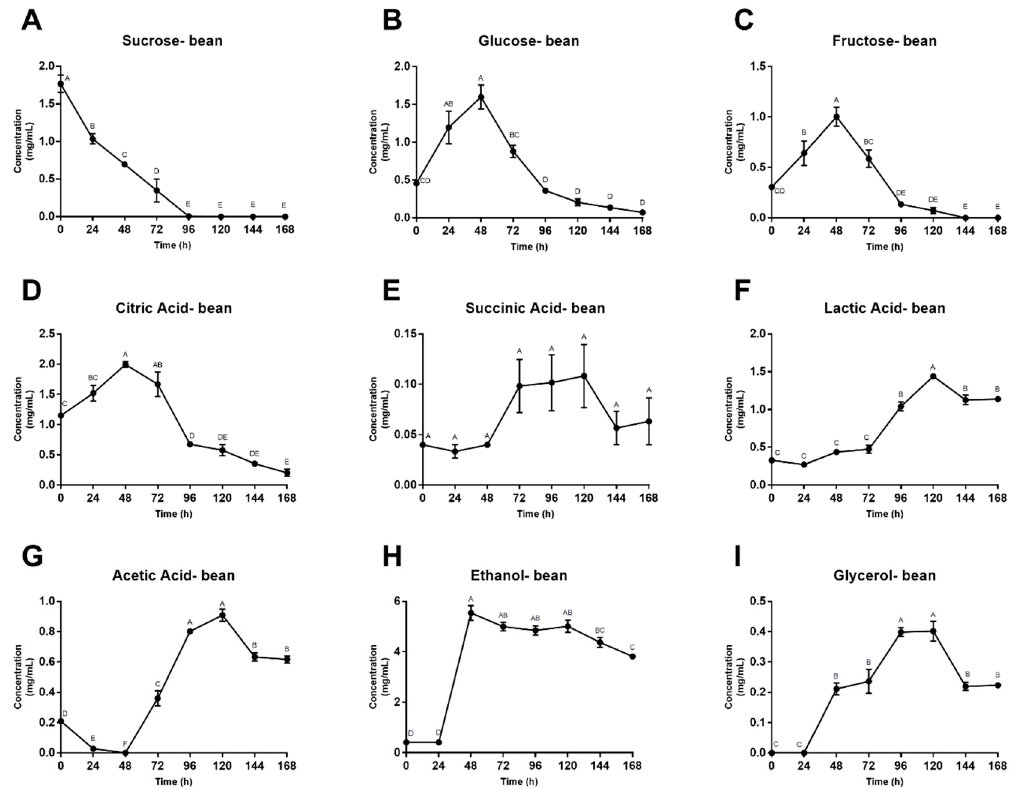
Figure 4. ( A – I ) Concentration of fermentation substrates and metabolites in cocoa beans across 168 h. Values are presented as the mean ± SEM of fermentation replicates. Significance between time points was determined by one-way ANOVA and Tukey’s HSD post-hoc test ( p < 0.05). Time points with different letters are significantly different values.